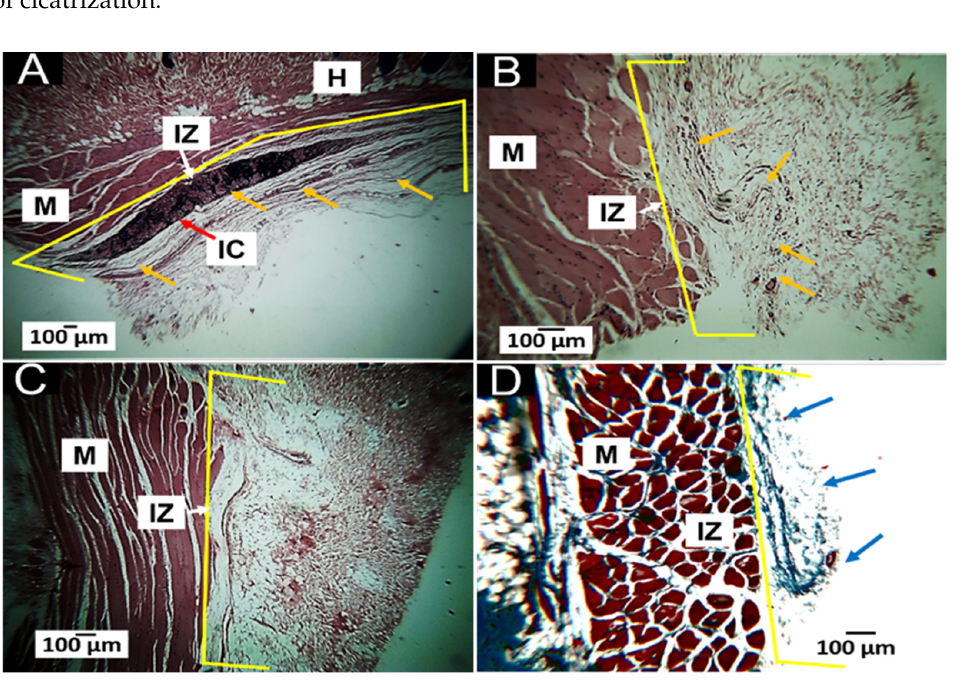
Figure 10. Subdermal implant formulation T4, 75%G:25%CS. ( A ): Implantation at 30 days, the image at 4×, H&E technique. ( B ): Implantation at 60 days, the image at 10×, H&E technique. ( C ): Implantation at 90 days, the image at 10×, H&E technique. ( D ): Implantation at 90 days, the image at 10×, MT technique. M: muscle. IZ: implantation zone. IC: inflammatory cells. Yellow arrow: fragments of the biomaterial. Red arrows: inflammatory cells. Blue arrows: connective tissue (type I collagen).